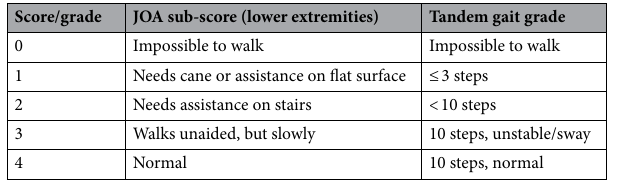
Table 1. Comparisons of each item between JOA sub-score for lower extremity and tandem gait